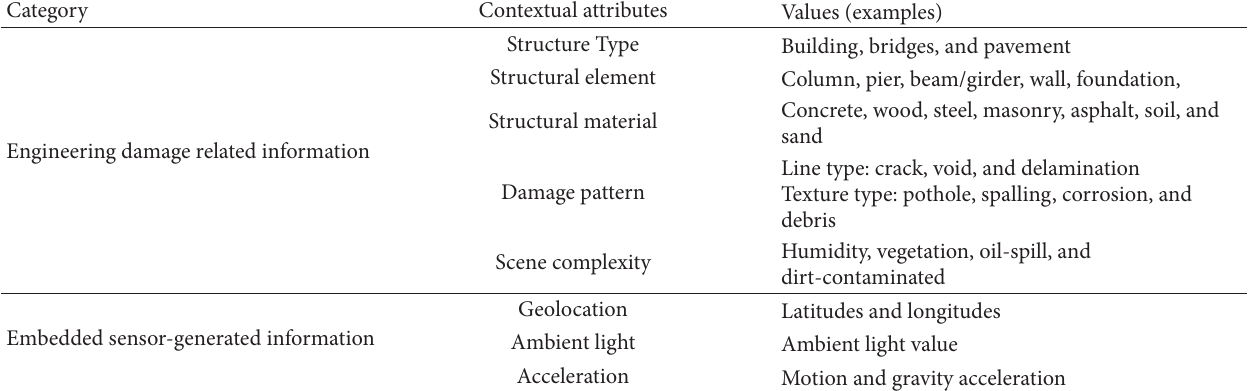
Table 1: Contextual information examples: engineering damage related empirical and embedded sensor-generated